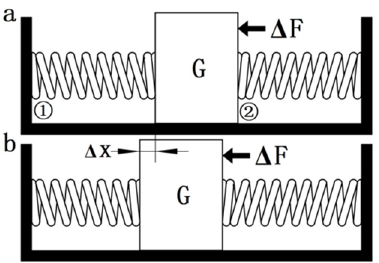
Figure 10. Compound springs model for analogy to actuator based on the antagonism principle. ( a ) The two springs are in a balanced state. ( b ) The external force causes two springs to elongate and contract respectively.